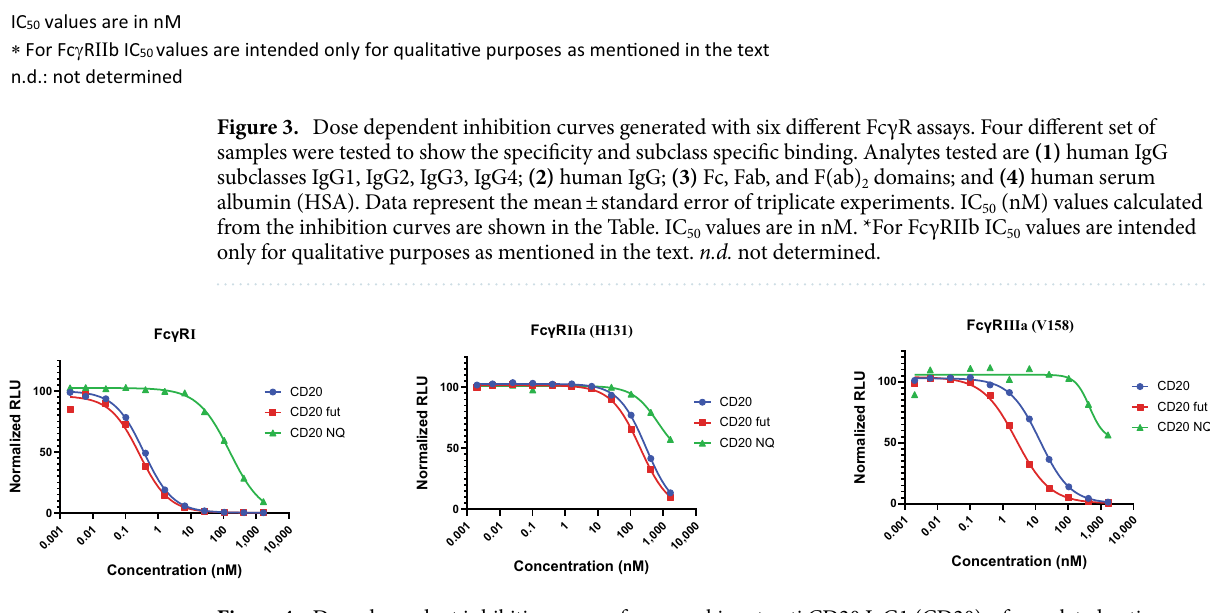
Figure 4. Dose dependent inhibition curves for recombinant anti CD20 IgG1 (CD20), afucosylated anti CD20 (CD20 fut), and deglycosylated anti CD20 (CD20 NQ) on FcγRI, FcγRIIa (H131) and FcγRIIIa (V158). Responses for two variants of FcγRII and FcγRIII were similar therefore only one variant is shown fusion protein and one NIST standard. Experiments with these eight antibodies generated 48 IC 50 values (Fig. 5). Several trends seen in this panel are similar to those seen in previous experiments and include: (a) FcγRI has the highest affinity whereas FcγRIIb has the lowest affinity among six receptors; (b) affinity of FcγRIIa (H131) is only slightly higher compared to R131 variant for IgG1 antibodies; (c) for same IgG1 panel, FcγRIIIa (V158) has six–tenfold higher affinity compared to FcγRIIIa (F158). However, there were some observations distinct to this panel including minimal or no binding of Panitumumab (IgG2) to any of the receptors except for FcγRIIa (H131) and that Pembrolizumab (IgG4) strongly interact only with FcγRI. In addition, among the five therapeu-